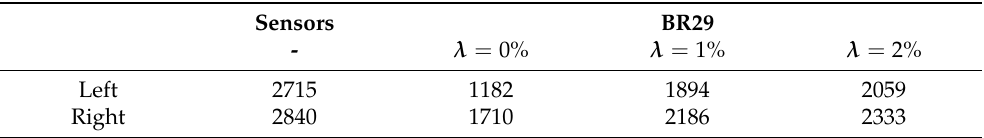
Table 5. Simulation 3: the number of source patches that produced signals that were detectable at least on one source montage channel ( Ndt1 > 0 or Ndt2 > 0, SNR >= 15 dB). The total number of simulated patches per hemisphere was 4098.